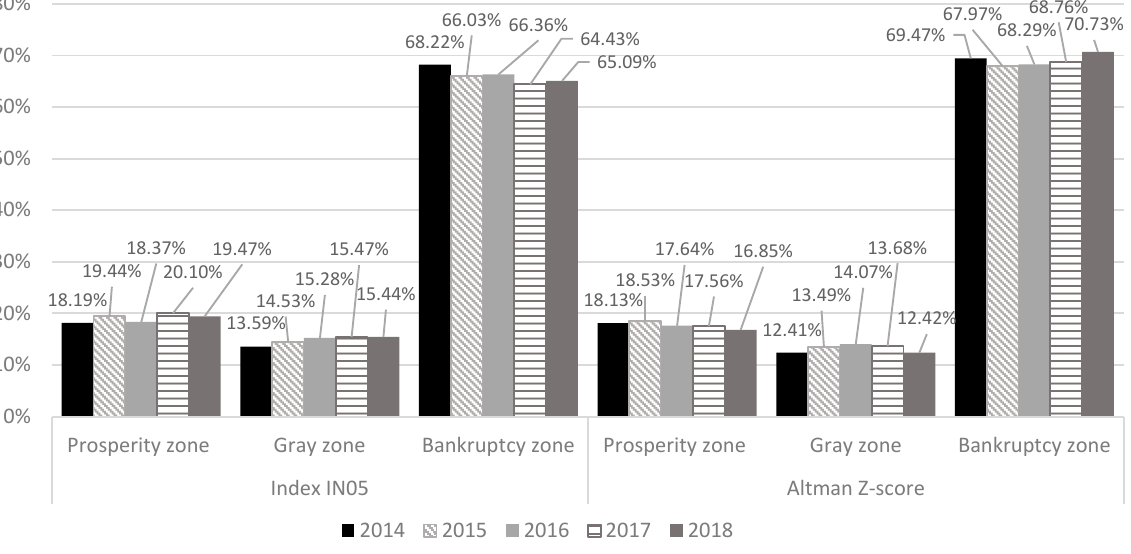
Figure 11. Comparison of financial performance results calculated using Altman’s Z-score and IN05 index.